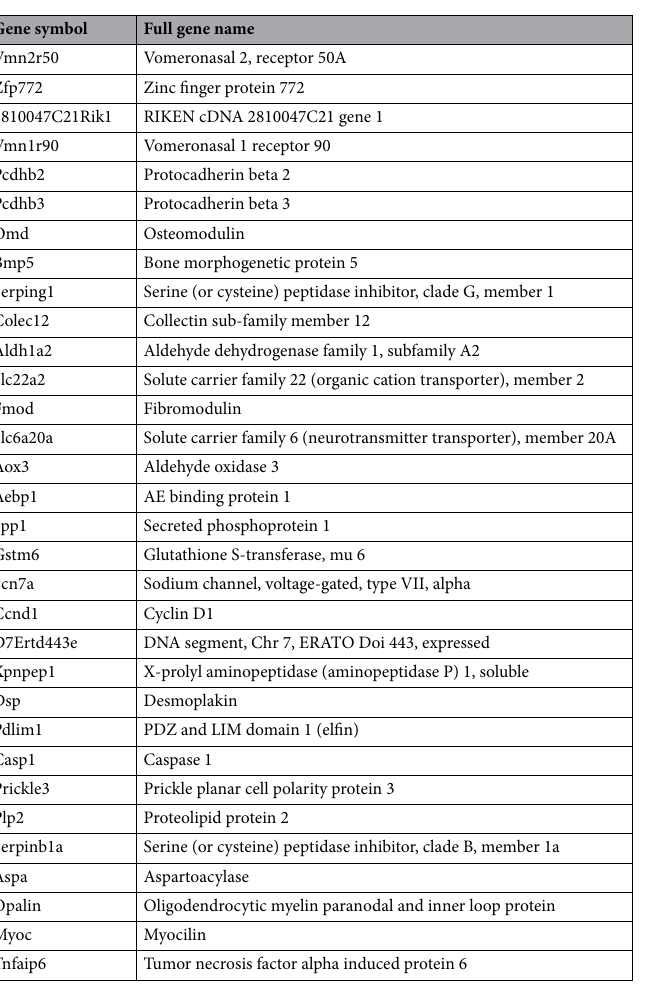
Table 1. List of DEGs in Xpnpep1 −/− hippocampus identified by microarray